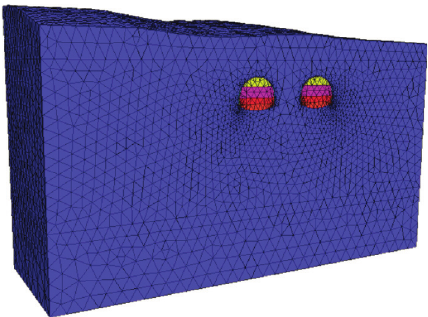
Figure 3: Grid division of the calculation model.